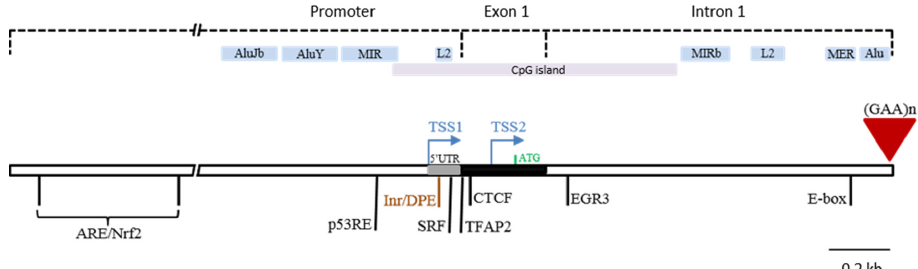
Figure 1. Regulatory elements in the FXN locus. Repetitive sequences, regulatory signals, and transcription factor binding sites present in the promoter region, exon 1 and the region surrounding GAA expansion within intron 1. ARE (Antioxidant Response Element); SINE (Short Interspersed Nuclear Element) family, which includes AluJb, AluY, Alu1, MIR and MIRb elements; MER1 (primate-specific MEdium Reiteration 1); Inr (mammalian Initiator); DPE (Downstream Promoter Element); L2, a specific LINE (Long Interspersed Nuclear Element), E-box (Enhancer-box); p53RE (p53 Responsive Element) and CpG (Cytosine-phosphoguanine) island. Transcription factor binding sites Nfr2 (or NFE2L2, Nuclear Factor (Erythroid-derived 2)-Like 2), SRF (Serum Response Factor), TFAP2 (Transcription Factor AP-2) and EGR3 (Early Growth Response factor 3). TSS1 and TSS2 (Transcription Start Site 1 and 2), 5’UTR (Untranslated Region 5’) and GAA triplet expansion